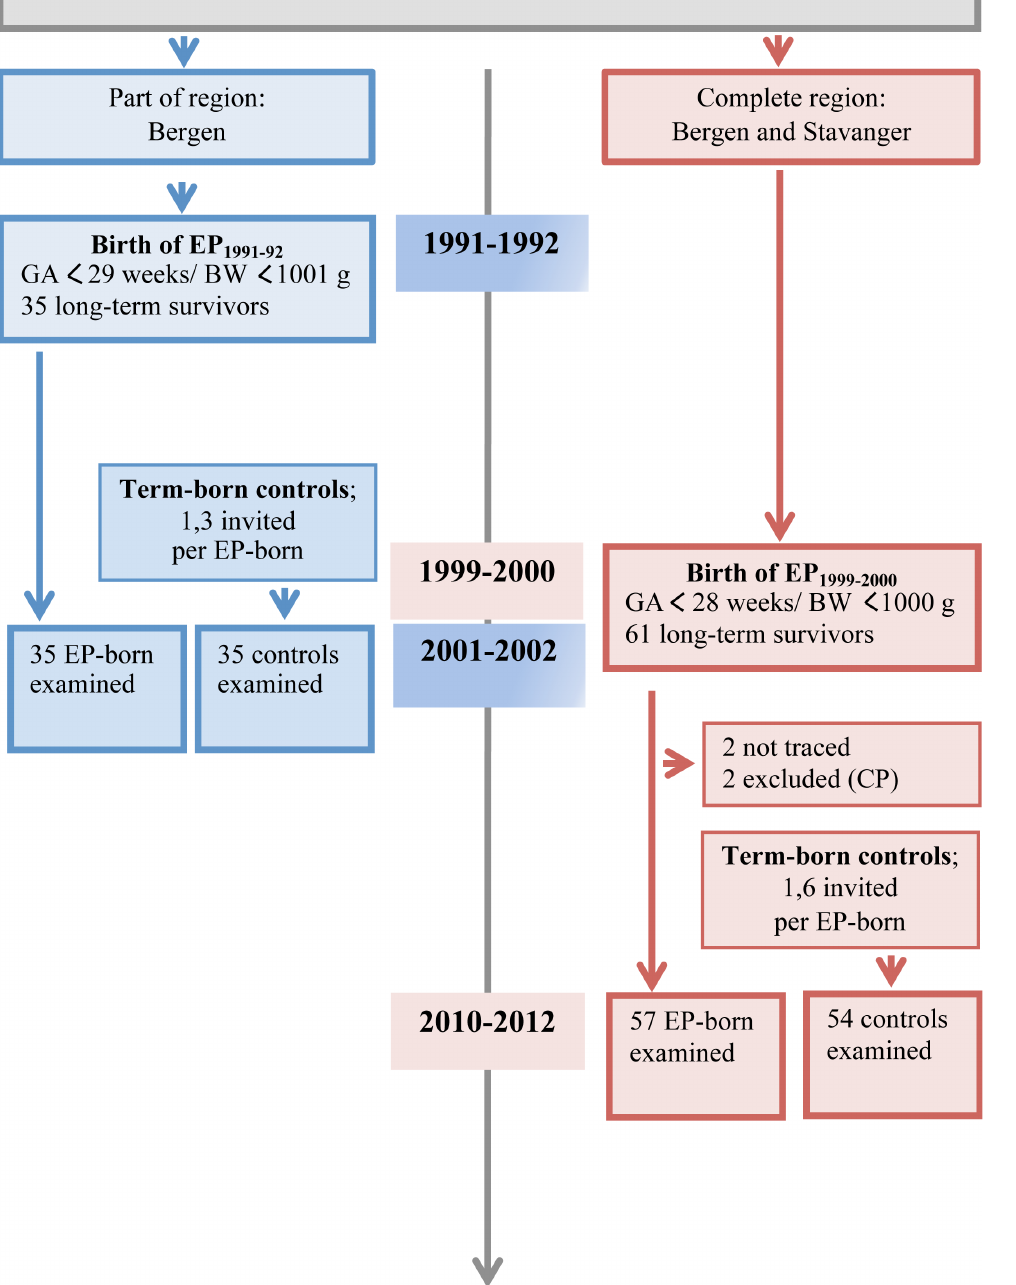
Fig 1. The recruitment of subjects in two cohorts of premature (EP) and matched term-born subjects, one cohort born in 1991 – 92 and examined in 2001 – 2002, and one cohort born in 1999 – 2000 and examined in 2010 – 2012.